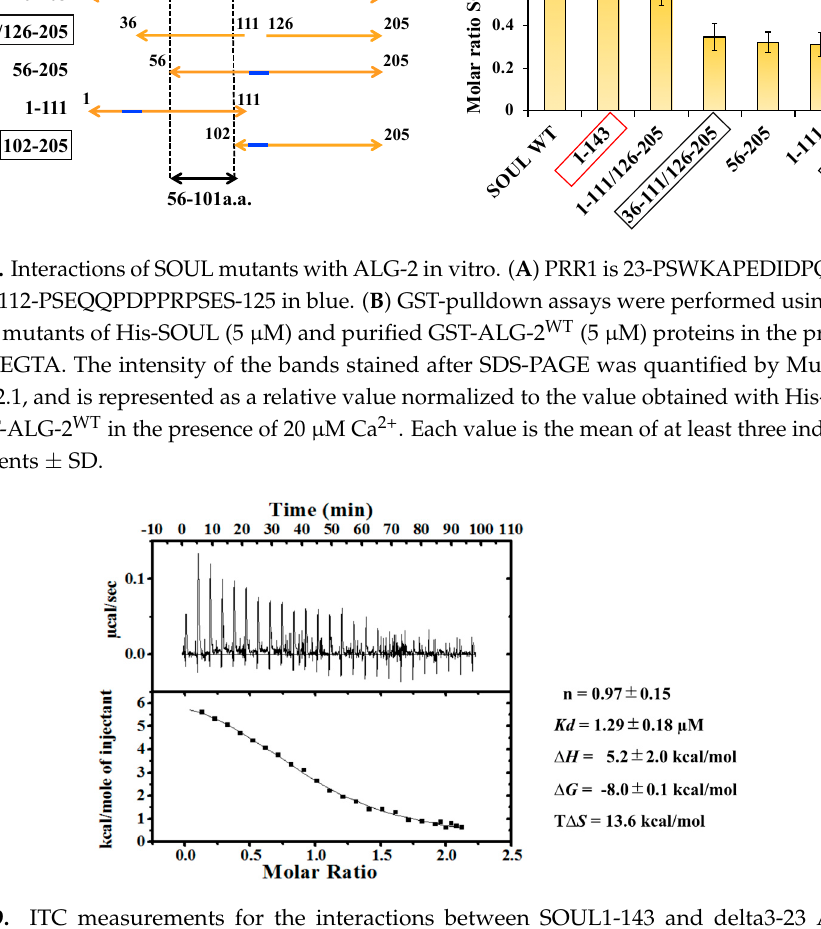
Figure 8. Interactions of SOUL mutants with ALG-2 in vitro. ( A ) PRR1 is 23-PSWKAPEDIDPQP-35 and PRR2 is 112-PSEQQPDPPRPSES-125 in blue. ( B ) GST-pulldown assays were performed using various purified mutants of His-SOUL (5 µM) and purified GST-ALG-2 WT (5 µM) proteins in the presence of Ca 2+ or EGTA. The intensity of the bands stained after SDS-PAGE was quantified by Multi Gauge version 2.1, and is represented as a relative value normalized to the value obtained with His- SOUL WT and GST-ALG-2 WT in the presence of 20 µM Ca 2+ . Each value is the mean of at least three independent experiments ± SD.